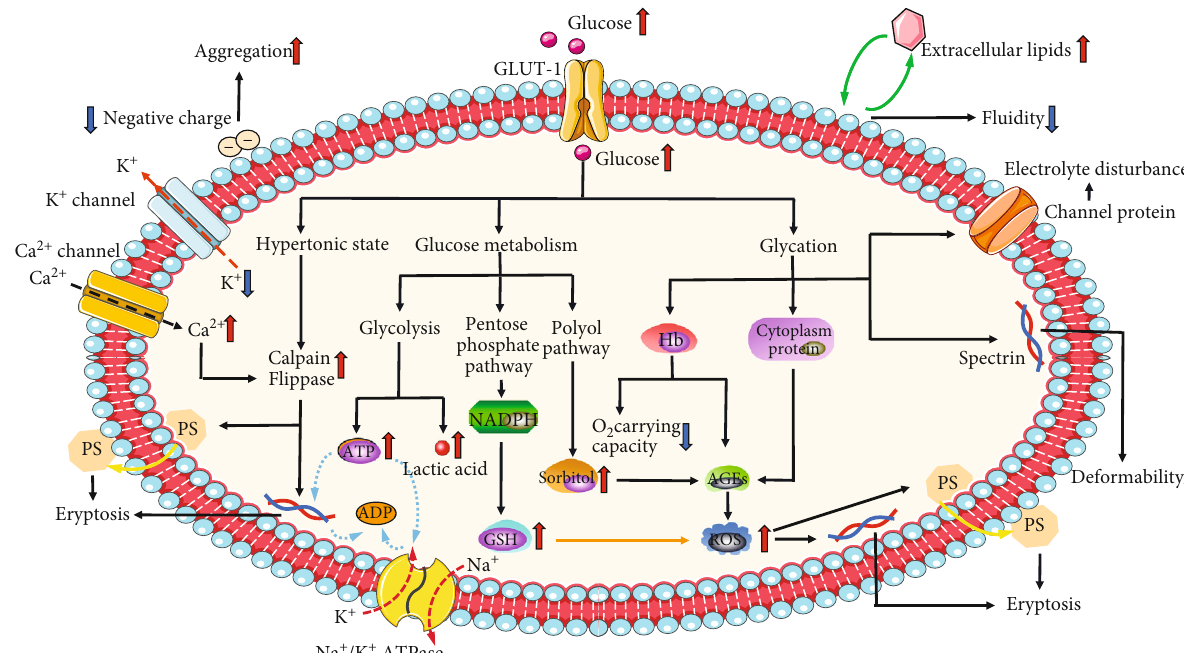
Figure 2: Glucose metabolism disorders in patients with diabetes profoundly a ff ect the morphological structure and physiological functions of erythrocytes. The black arrows indicate promoting function, and the orange arrows indicate inhibitory